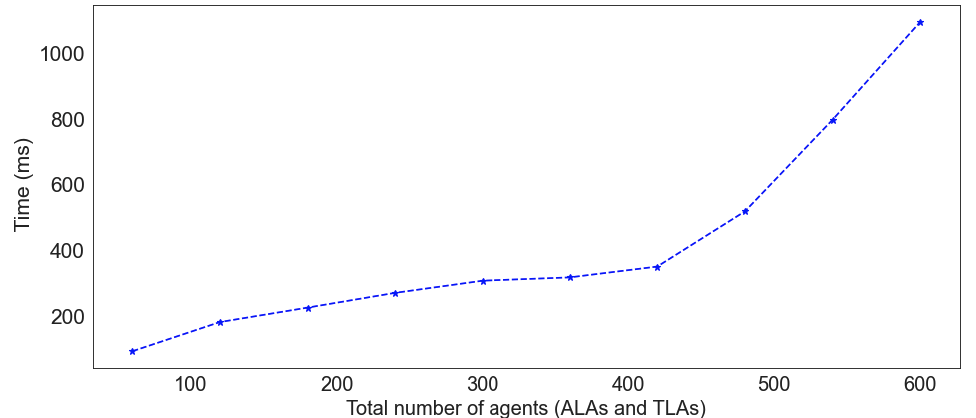
Figure 15. Mutual authentication and self-adaptations performed to mitigate fake node